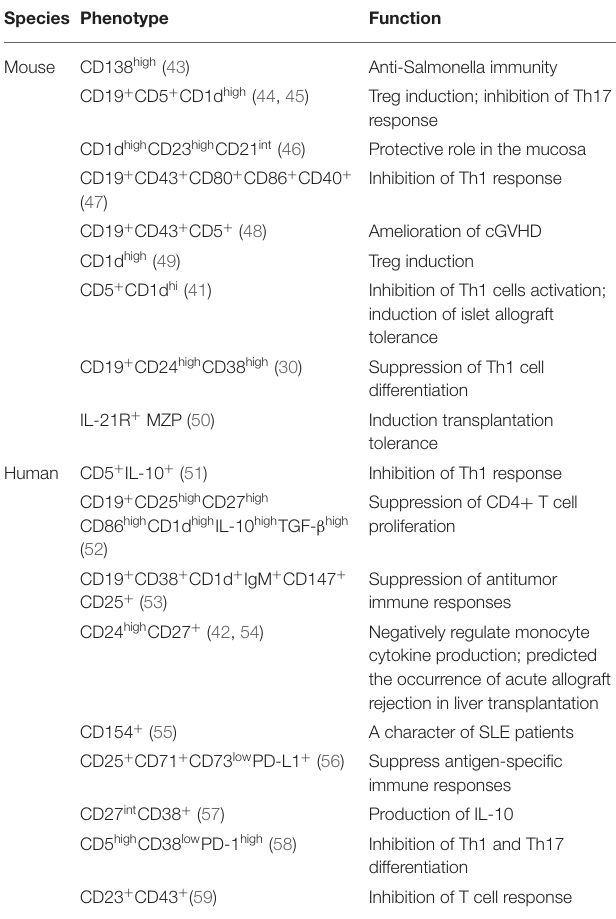
TABLE 1 | Phenotypes of IL-10 +